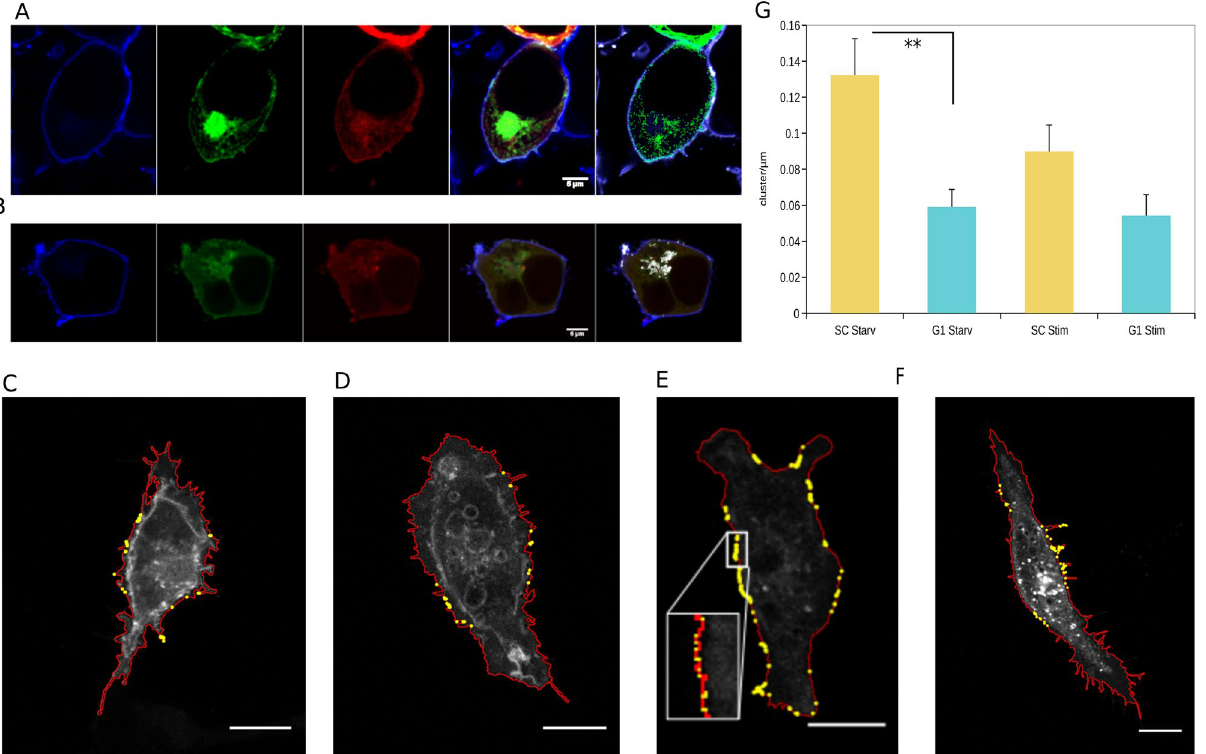
Figure 2. Microscopic characterisation of FGFR2 clusters under starvation and on stimulation in the presence and absence of GRB2. ( A – B ) Distribution of FGFR2 and GRB2 at the plasma membrane. ( A ) HEK293T serum starved, ( B ) HEK293T FGF9 stimulated. Left to right: membrane stained with DiB, FGFR2-GFP, GRB2-mRFP, overlay, co-localisation (clusters: white dots). Scale bar = 5 µm. ( C – F ) Confocal microscopic images of single z-slice of plasma membrane localized FGFR2-mCherry and cholesterol-Cy5 cluster based on the ImageJ Cluster plugin; membrane (red) and size superimposed clusters (yellow). ( C ) Control (SC) serum-starved. ( D ) GRB2- depleted (G1) serum starvation. ( E ) Control (SC) 20 min. after FGF9 stimulation. Inset shows expanded image of spacing of clusters demonstrating that although there appears to be a large number of clusters in the image they are distal from one another. ( F ) GRB2 reduced (G1) 20 min. after FGF9 stimulation. Scale bar = 5 µm. ( G ) Quantification of identified cluster/µm in SC and G1 cells under serum starvation and in SC and G1 20 min. after FGF9 stimulation. Significant difference between SC and G1 starvation ( p =